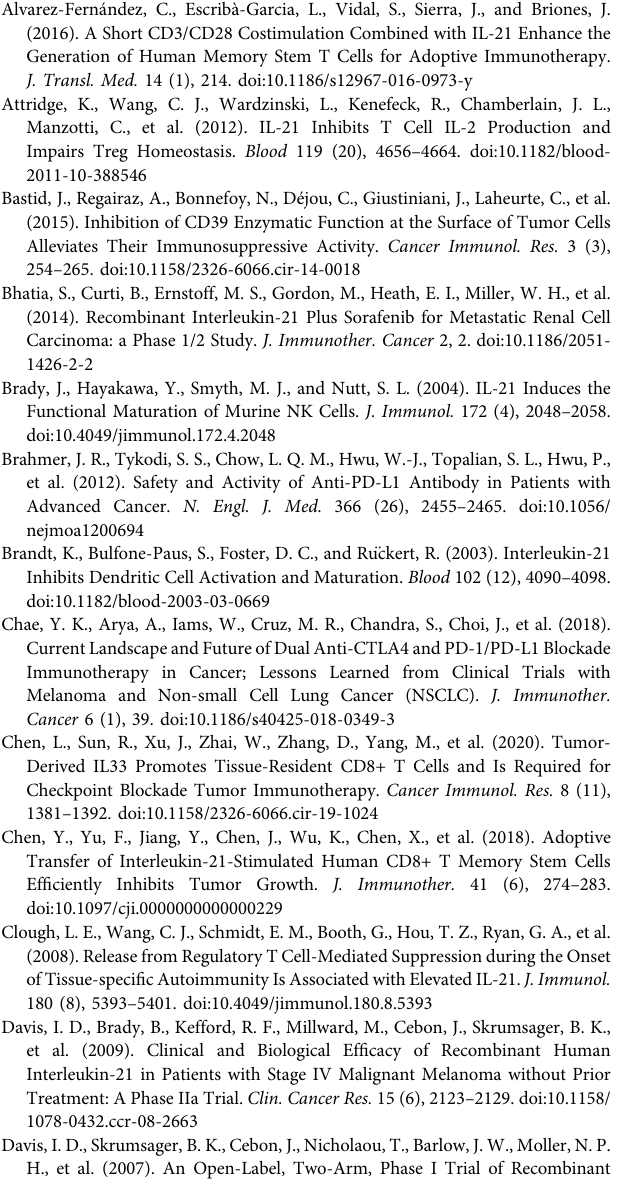
Supplementary Figure S1 | Characterization of IL21R + peripheral immune cells. (A) Representative fl ow cytometry gating strategy for identi fi cation of immune cell population. Supplementary Figure S2 | Administration of HSA-IL21 and PD-1 mAbs additively inhibited tumor growth. (A) CT26-MSLN tumor cells (1 × 10 6 )